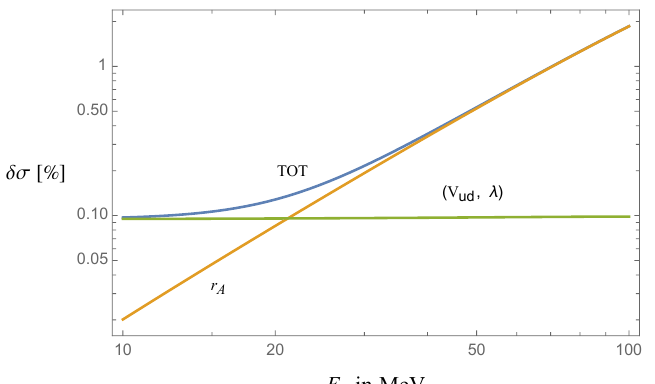
Figure 3 . Overall 1 σ uncertainty variation of the IBD cross section as a function of the neutrino energy (blue curve). We also indicate the contribution from the errors associated to the V measurements (green curve), in this case we consider the conservative scenario without correlation induced by the neutron lifetime constraint, and from the uncertainty on g radius (orange curve). Again, we consider the most conservative case.